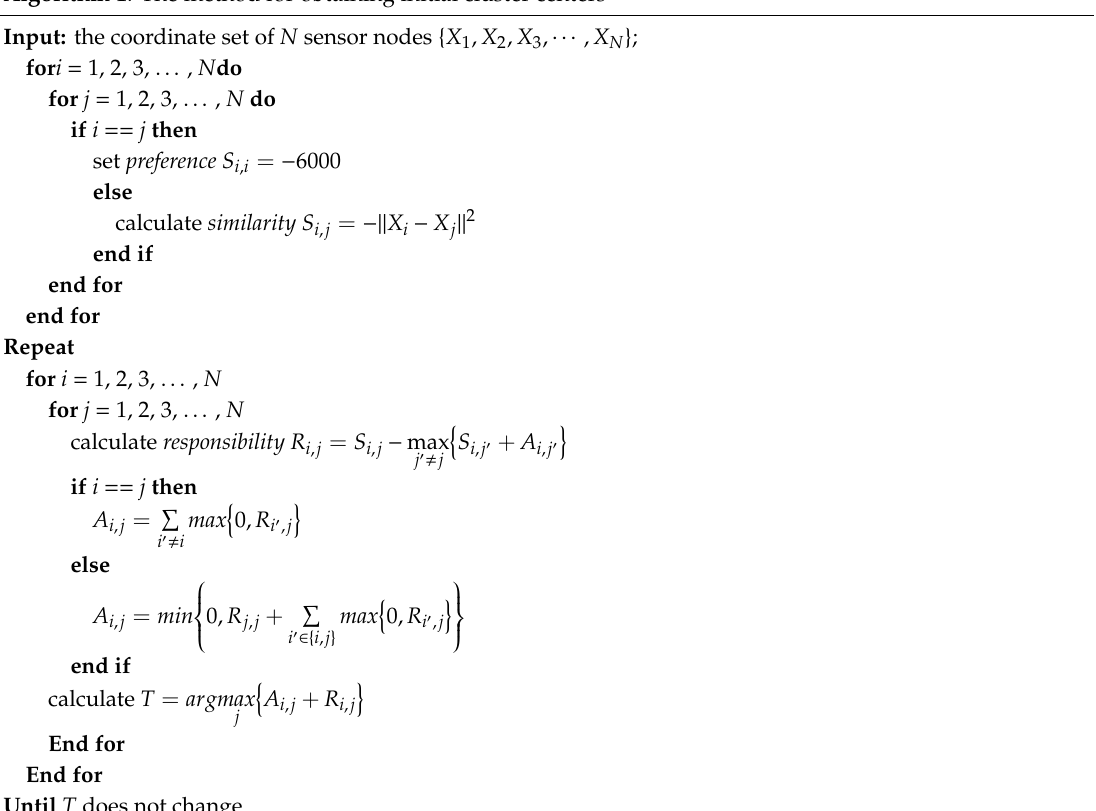
Algorithm 1 : The method for obtaining initial cluster